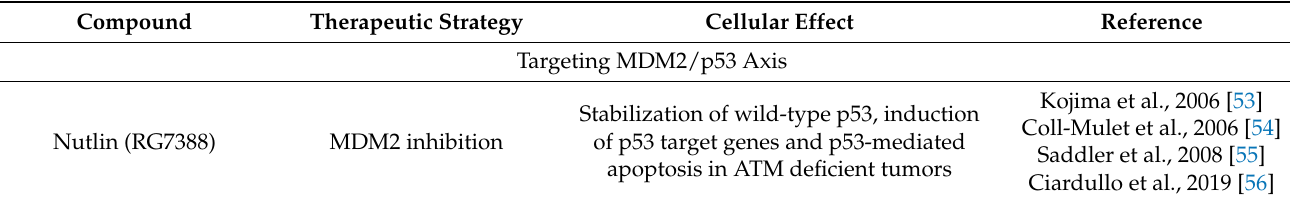
Table 2. Pre-clinical studies with new therapeutic agents targeting defective p53 pathway.